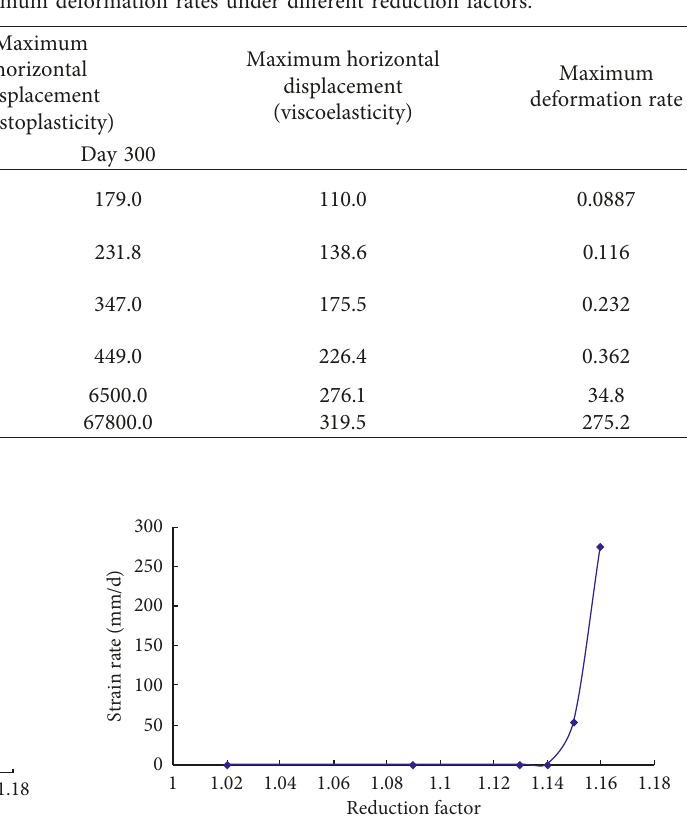
Figure 12: Creep displacement diagram of key points of slip-surface soil with different reduction factors: (a) 1.02; (b) 1.09; (c) 1.13; (d) 1.14; (e) 1.15; (g) 1.16. (f) Creep curve for the first 20 days when the strength reduction factor � 1.15. (h) Creep curve for the first 20 days when the strength reduction factor � 1.16. Table 4: Maximum displacement and maximum deformation rates under different reduction factors.